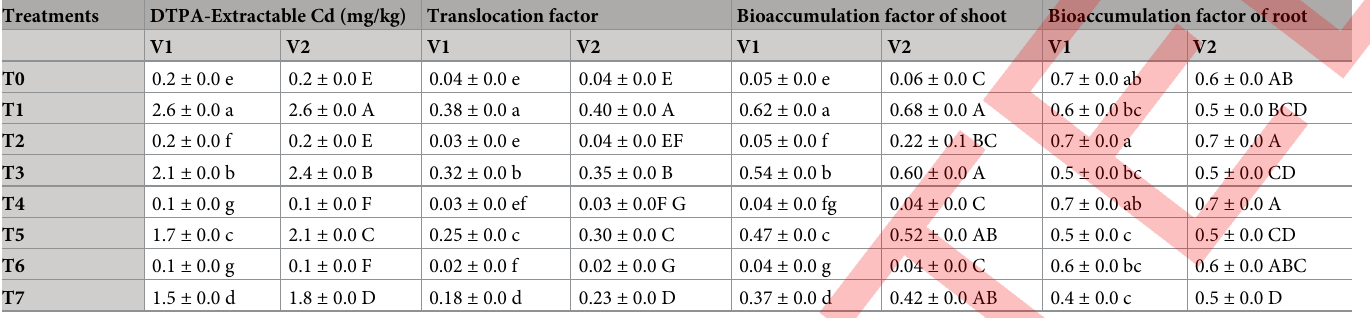
Table 3. Effect of biochar and compost on DTPA-extractable Cd from soil and translocation and bioaccumulation factor of Spinach grown in cadmium contami- nated soil. The mean of three replicates and standard deviation are presented. Different letters show the significant difference among treatments. Treatments as men- tioned in Table